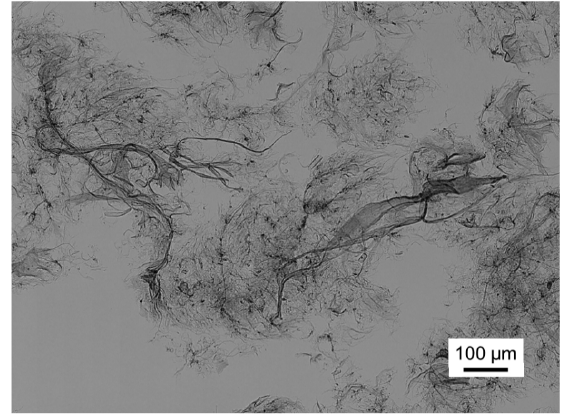
Figure 1. An image of the microfibrillated cellulose (MFC) used in this study. The distributions of length and width are very broad.